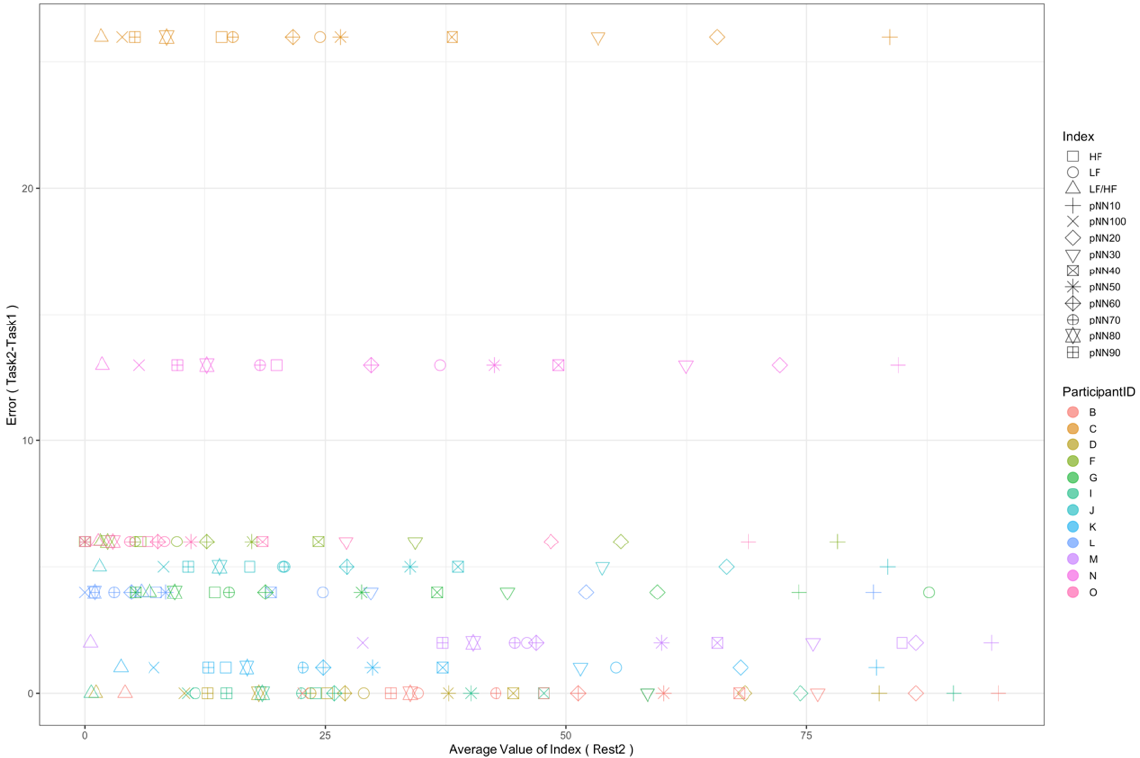
Figure 10. Scatterplot between the number of errors of Task2-Task1 vs. the HRV indexes during Rest2.